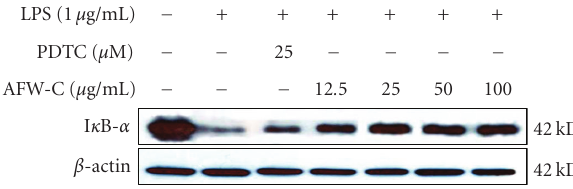
graph, was 54.7 μ g/mL (Figure 4(a)). The CH 2 Cl 2 fraction (Figure 4(b)). The potential cytoxicity of CH 2 Cl 2 fraction of AFW was evaluated by MTT assay after incubating cells for 24 hours in the absence or presence of LPS; cell viabilities were not a ff ected at the concentrations used (12.5, 25,